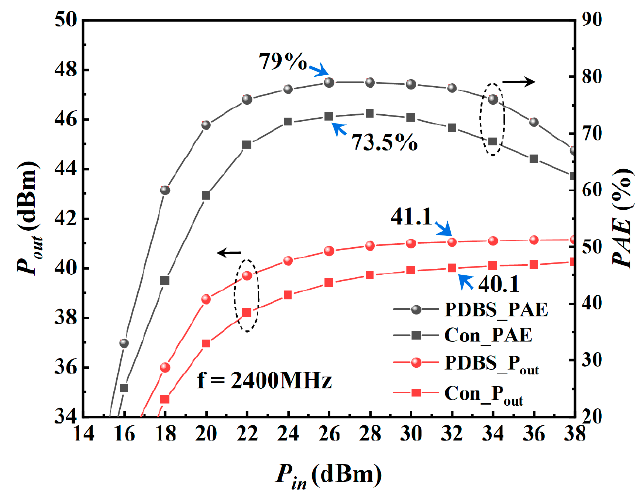
Figure 12. Large-signal performance of both structures at 2400 MHz with= − 4 V, V ds = 20 V.